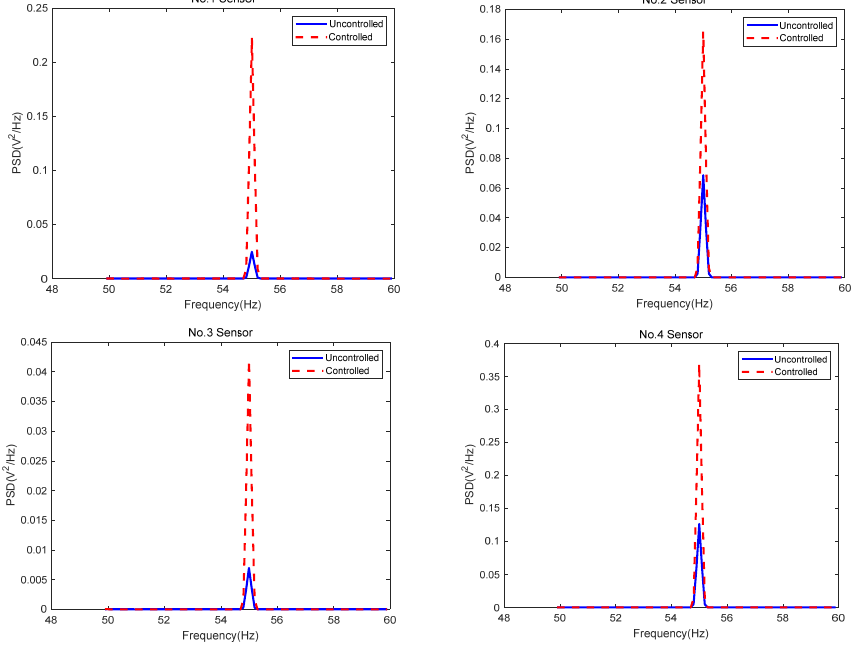
Figure 24. PSDs of sensor signals obtained by experiments. Table 9. RMS values of sensor signals.